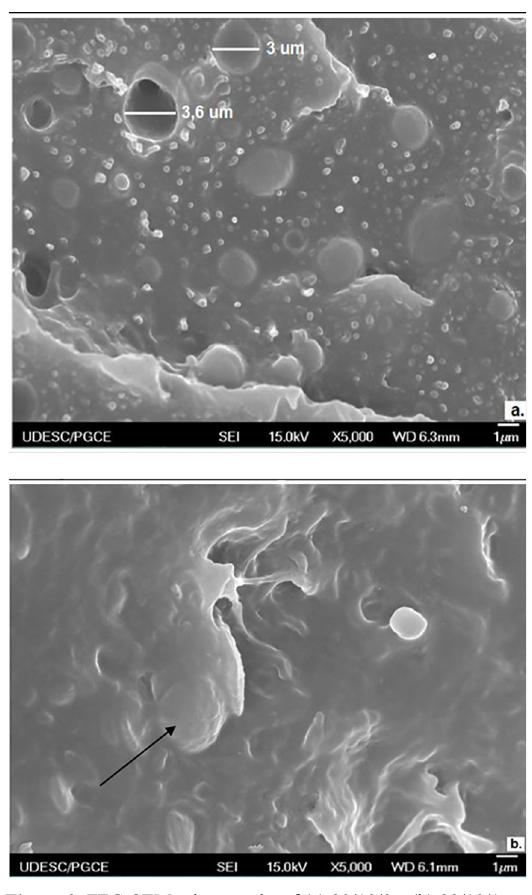
Figure 3. FEG-SEM micrographs of (a) 90/10/0 e (b) 89/10/1